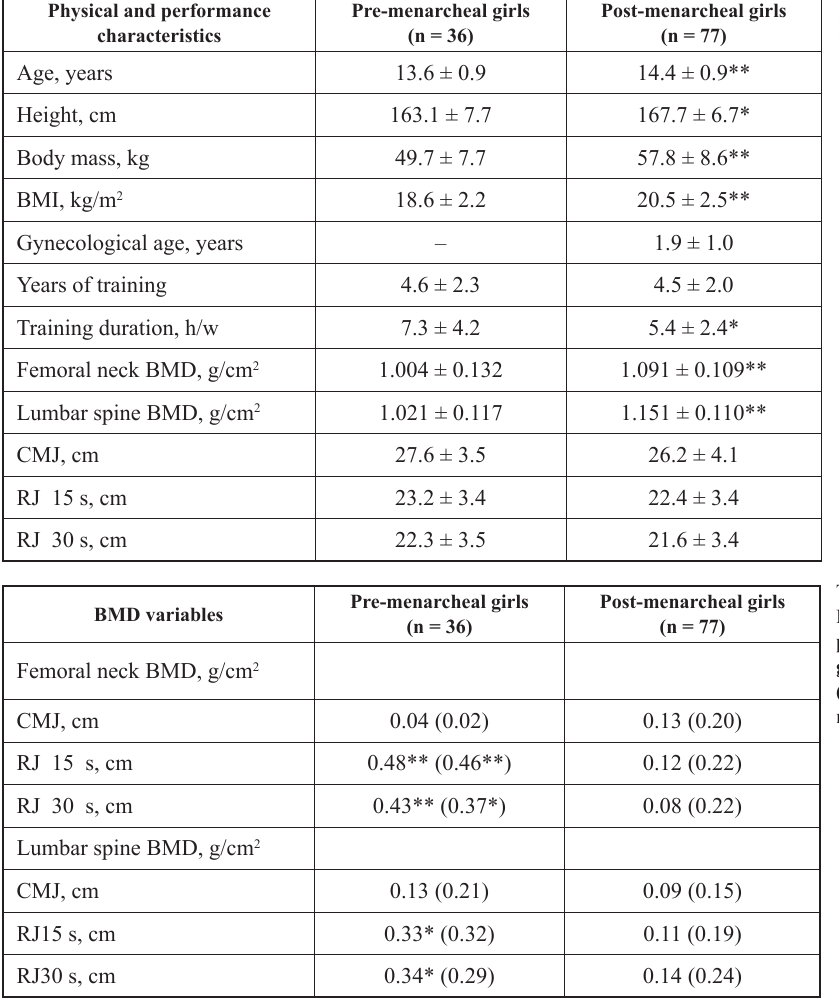
Table 1. Mean (± SD) physical and performance characteristics of the